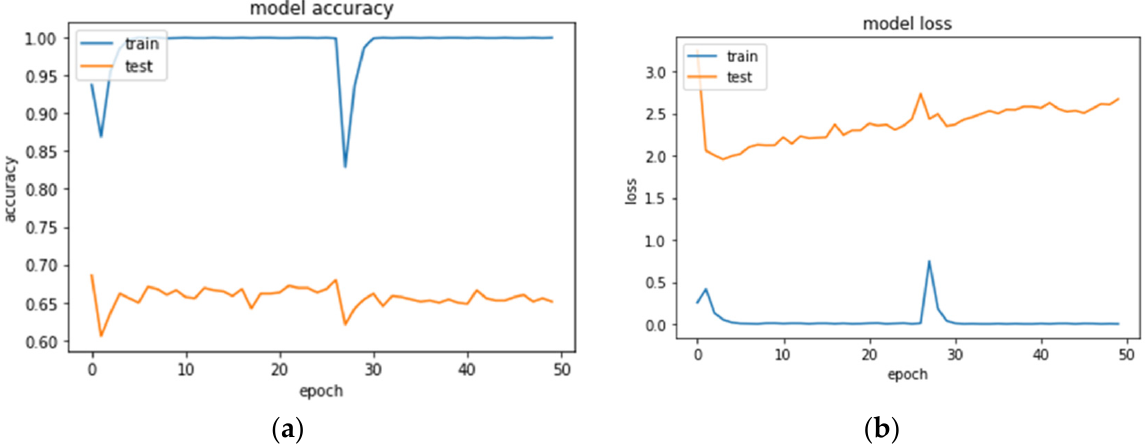
Figure 13. Training and testing of CNN model: ( a ) training and testing accuracy, ( b ) training and testing loss.